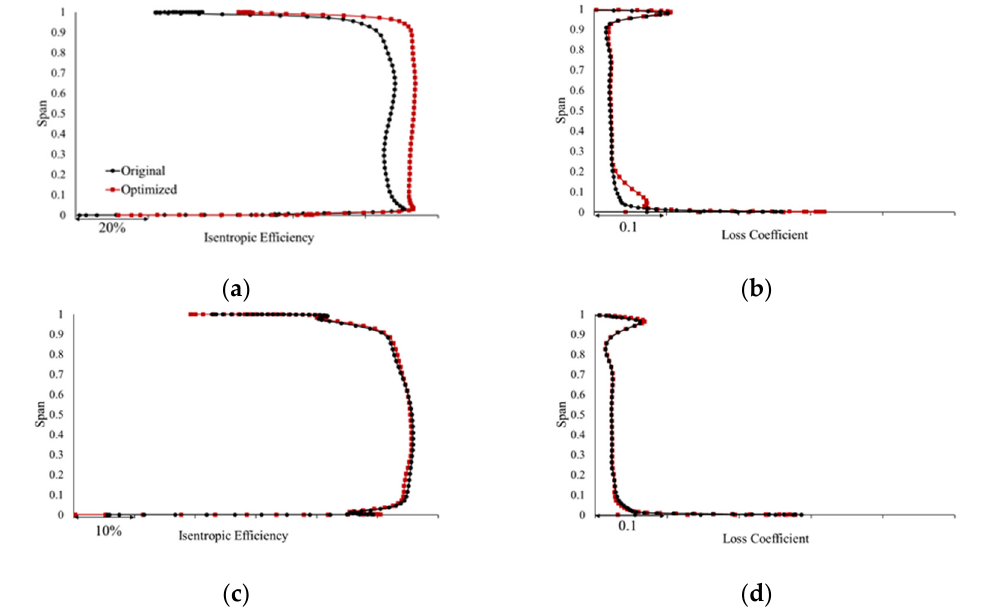
Figure 14. Efficiency spanwise distribution. ( a ) Efficiency of R1; ( b ) loss of S1; ( c ) efficiency of R2; ( d ) loss of S2.